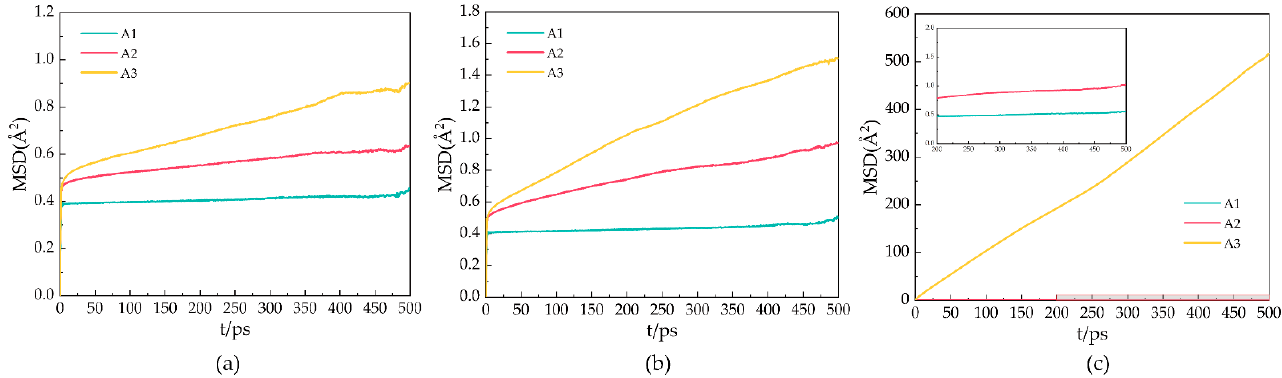
Figure 5. MSDs of oxygen atoms in water molecules of A1, A2, and A3 model after 500 ps at P = 2 MPa and three different temperatures for ( a ) T = 273 K, ( b ) T = 283 K, and ( c ) T = 293 K.